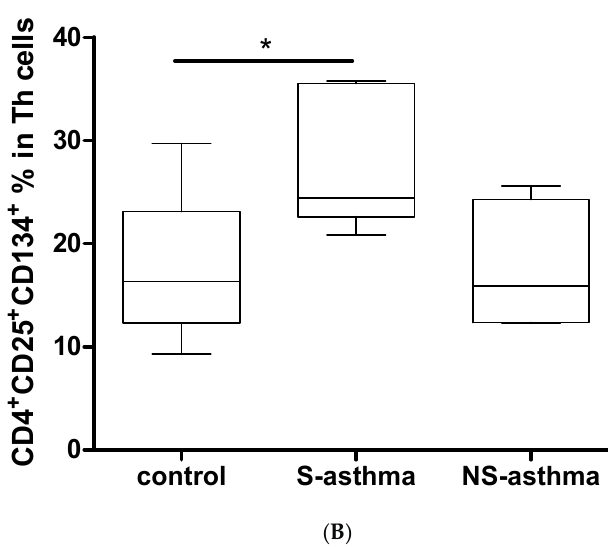
Figure 5. Determination of activated mitogen-specific CD4 + CD25 + CD134 + T cells from the in vitro whole blood in asthmatic patients and control. ( A ) The representative dot plot and gating strategy of activated CD4 + CD25 + CD134 + T cells in whole blood were shown; ( B ) The percentage of CD4 + CD25 + CD134 + T cells in asthmatic patients and control subjects was determined by flow cytometry ( n = 8 in each group). Statistical significances were indicated by * p < 0.05 (Mann-Whitney U test). S-asthma: steroid-treated asthmatic patients; NS-asthma: non-steroid-treated asthmatic patients, control: control